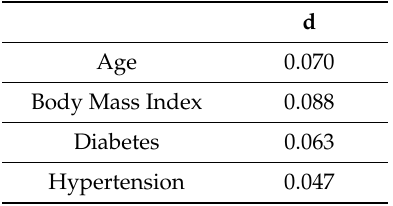
Table 1. Standardized di ff erences in propensity